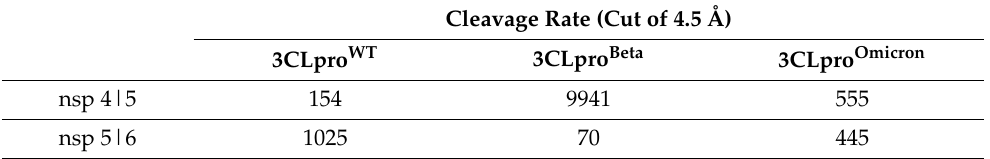
Table 3. Cleavage rates of different 3CLpro. To calculate the cleavage rate, the frequency at which the catalytic dyad of the 3CLpro protein approached the substrate was taken into account, taking into account a cutoff of 4.5